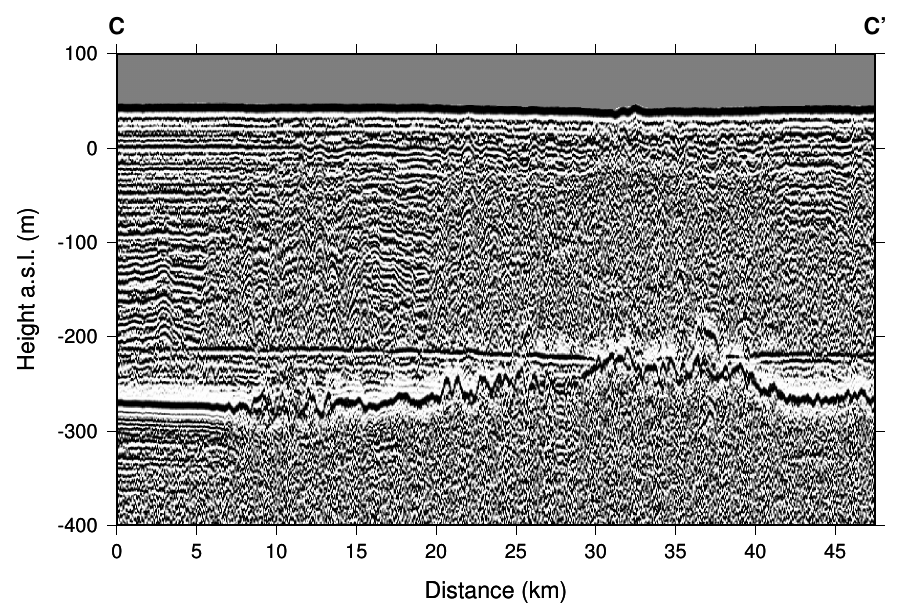
Fig. 3c. Radargram showing a 60ns profile acquired in 2001 ranging from C to C 0 (locations of are shown in Fig. 2a). The horizontal line at an elevation of approximately − 210m is a multiple reflection between aircraft and surface.